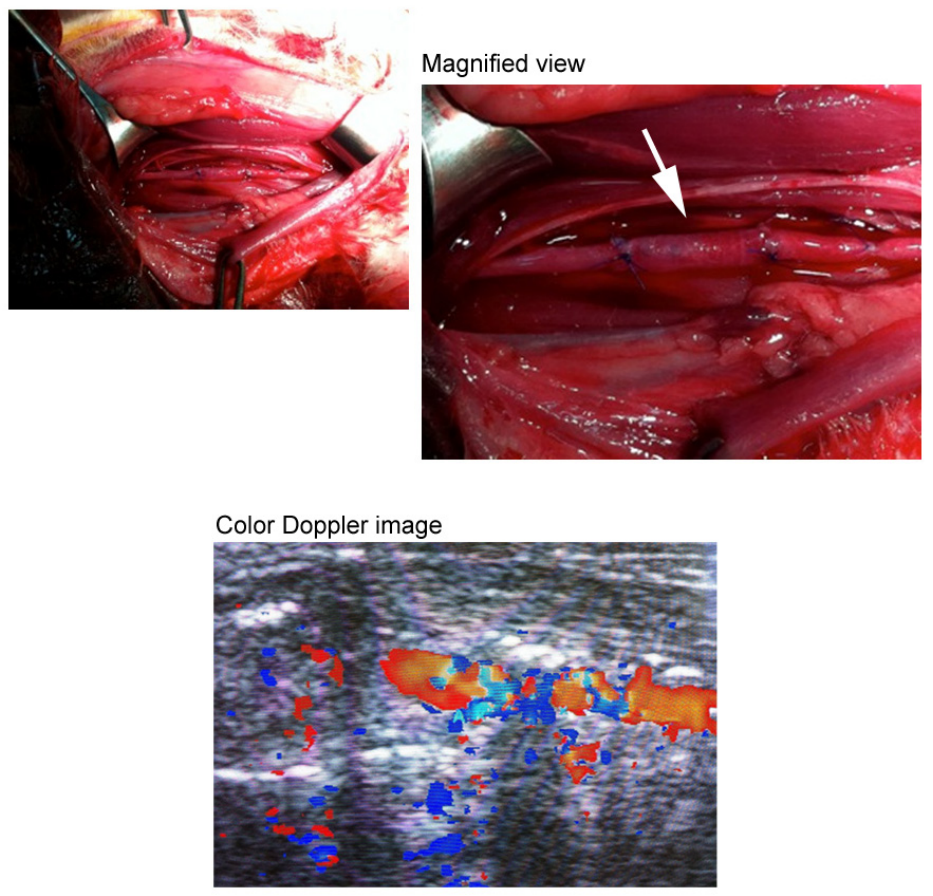
Figure 4. The multi-layered oriented collagen tube transplanted as a blood vessel graft for the carotid artery of a